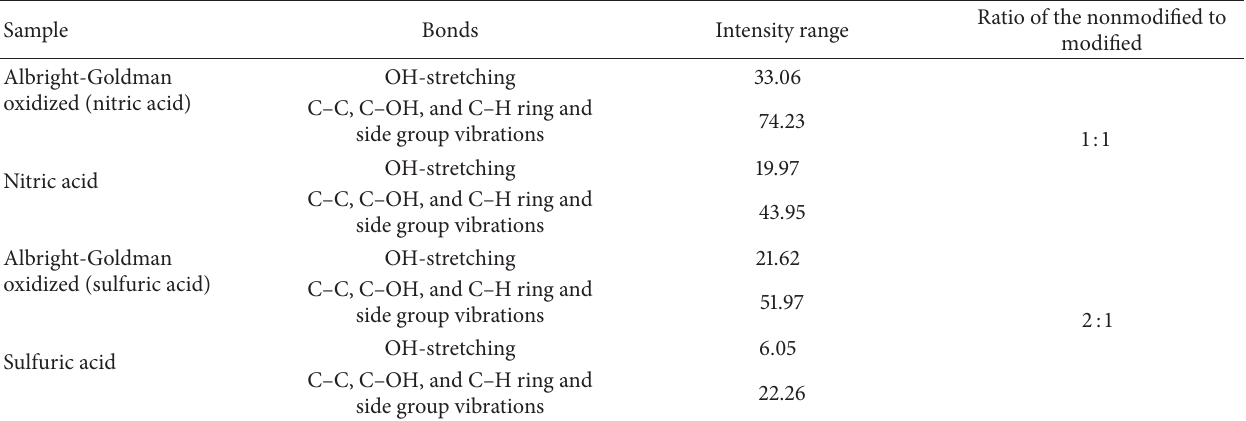
Table 3: The ratio of the OH stretch to the C–C, C–OH, and C–H ring and side group vibrations.